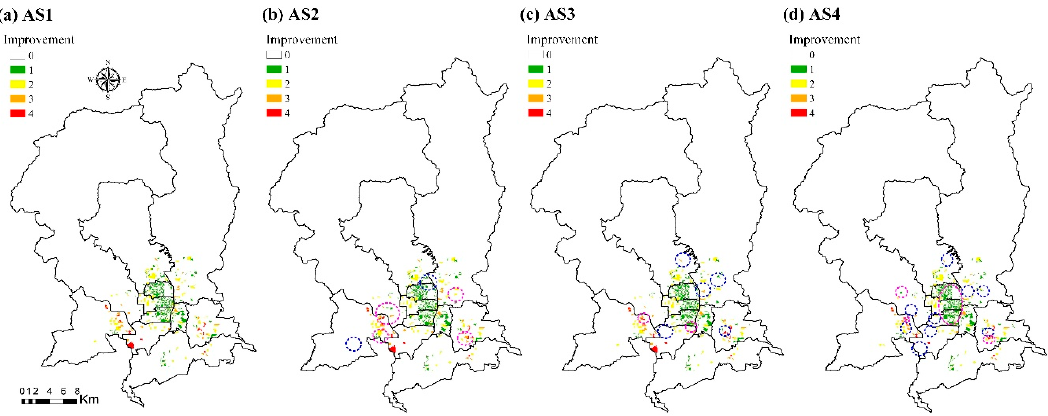
Figure 11. Decreased levels of climate risk in each section of village with the potential climate adaptation strategies for 2020. Note: Same as the note in Figure 10. The blue dotted circles for AS2, AS3 and AS4 indicate that the improvement decreases compared to AS1; the pink dotted circles for AS2, AS3 and AS4 indicate that the improvement increases compared to AS1.